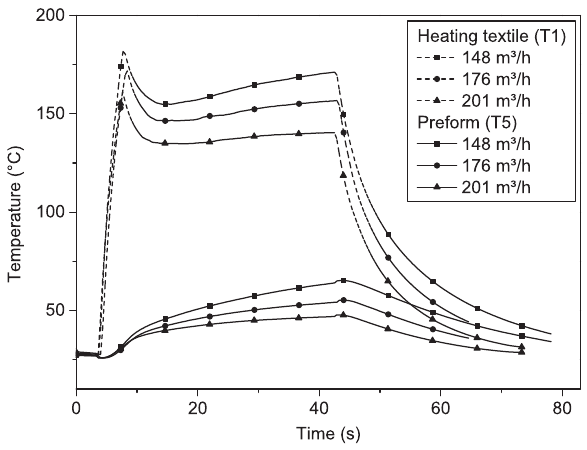
Figure 13 Influence of the gripping air stream on the heating